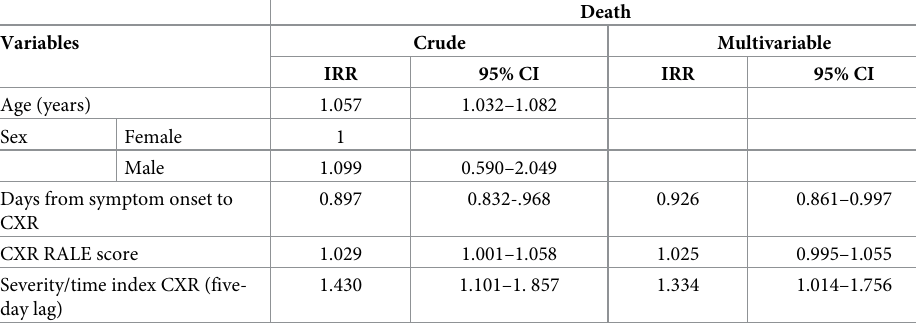
Fig 3. ROC curves. Receiver operating characteristic (ROC) curves of each measure of disease severity (red line) and respective severity/time index (blue line) in multivariable logistic models for death at 30 days, adjusted for age and sex. Considered measures of disease severity are computed tomography (CT) visual score of disease extension (panel A), chest X-rays (CXR) Radiographic Assessment of Lung Edema (RALE) score (panel B), CRP levels (panel C), and sO 2 levels (panel D). Horizontal axis: 1—Specificity from 0 to 1.00; vertical axis: Sensitivity from 0 to 1.00. https://doi.org/10.1371/journal.pone.0270111.g003 Table 3. Crude and sex- and age-adjusted associations with death in the validation